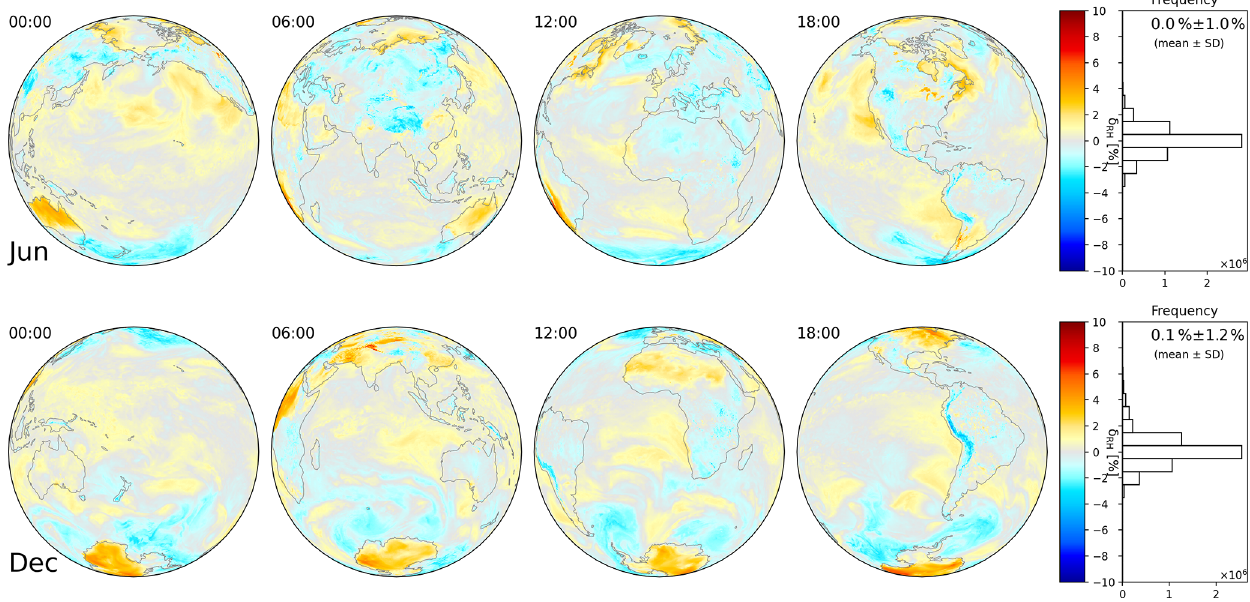
Figure 7. Deviation δ RH according to Eq. (19) for ERA5 at 00:00, 06:00, 12:00, and 18:00UTC on 18 June (top) and 18 December (bottom) 2018. The projection focuses on daytime for each time step. On the right, the frequency distribution and mean and SD are given for all hourly outputs of the respective day. Note that the mean deviation on 18 June 2018 is 0 by construction, as the parameters a and b (Eq. 14) are optimized for this day. Results for 18 March and 18 September 2018 are shown in Fig.